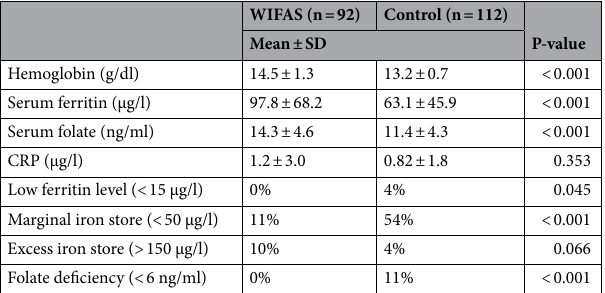
Table 3. Hemoglobin, iron, and folate status of adolescent girls at endline. SD standard division, WIFAS weekly iron-folic acid supplementation; means were compared using t-test. P-values < 0.05 were considered statistically significant.